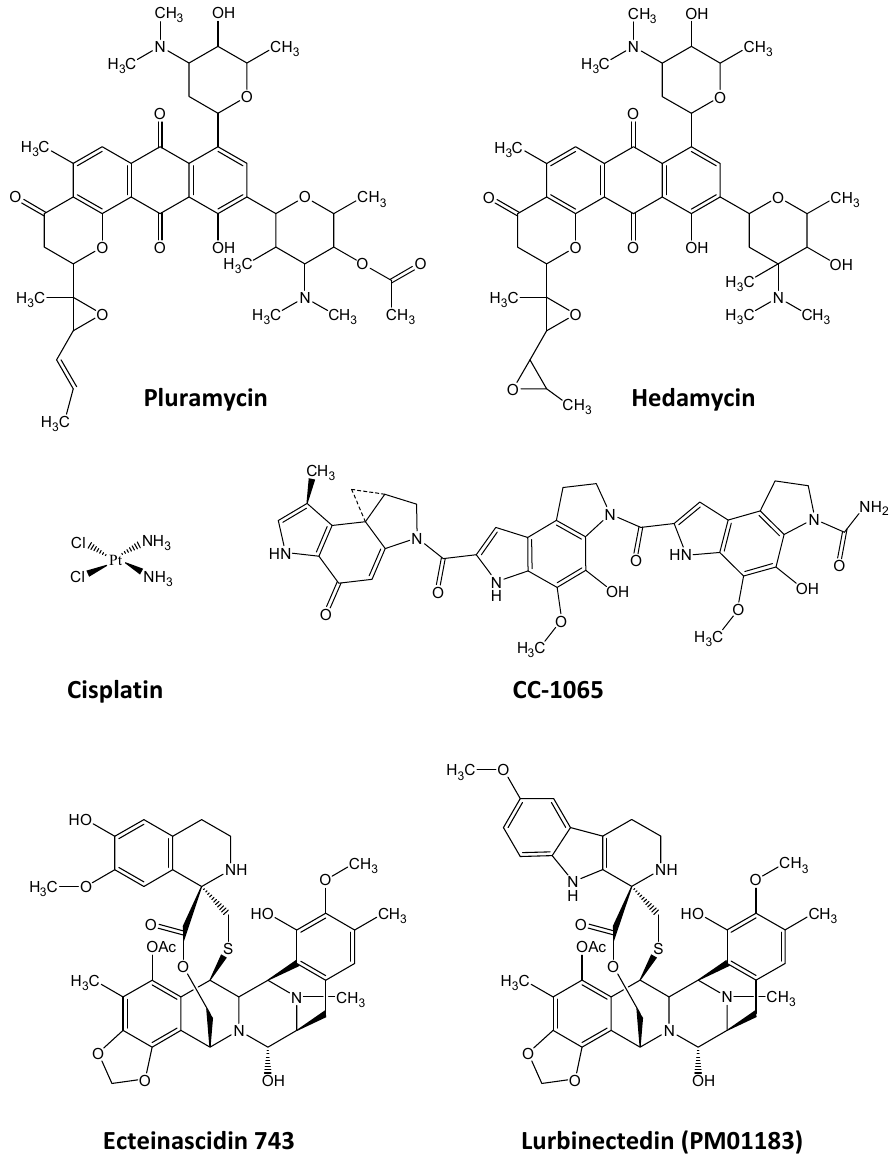
Figure 6. DNA alkylating drugs as inhibitors of transcription factors/DNA binding.